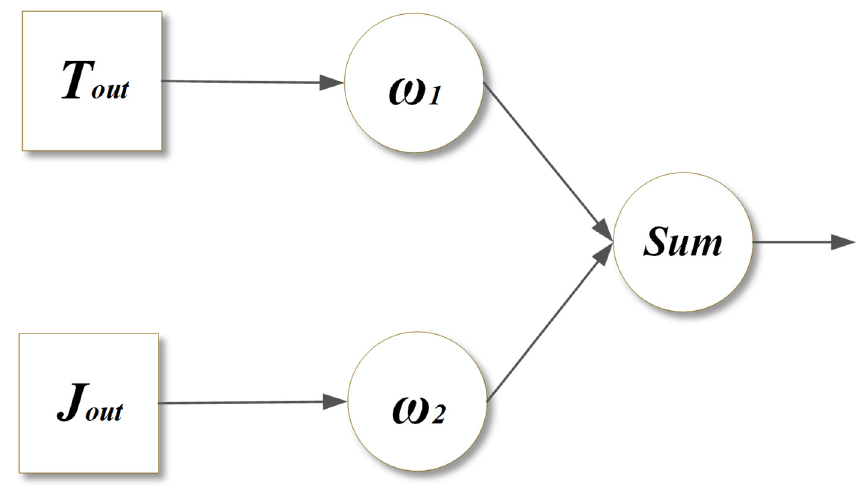
Figure 3. Feature Fusion Module.